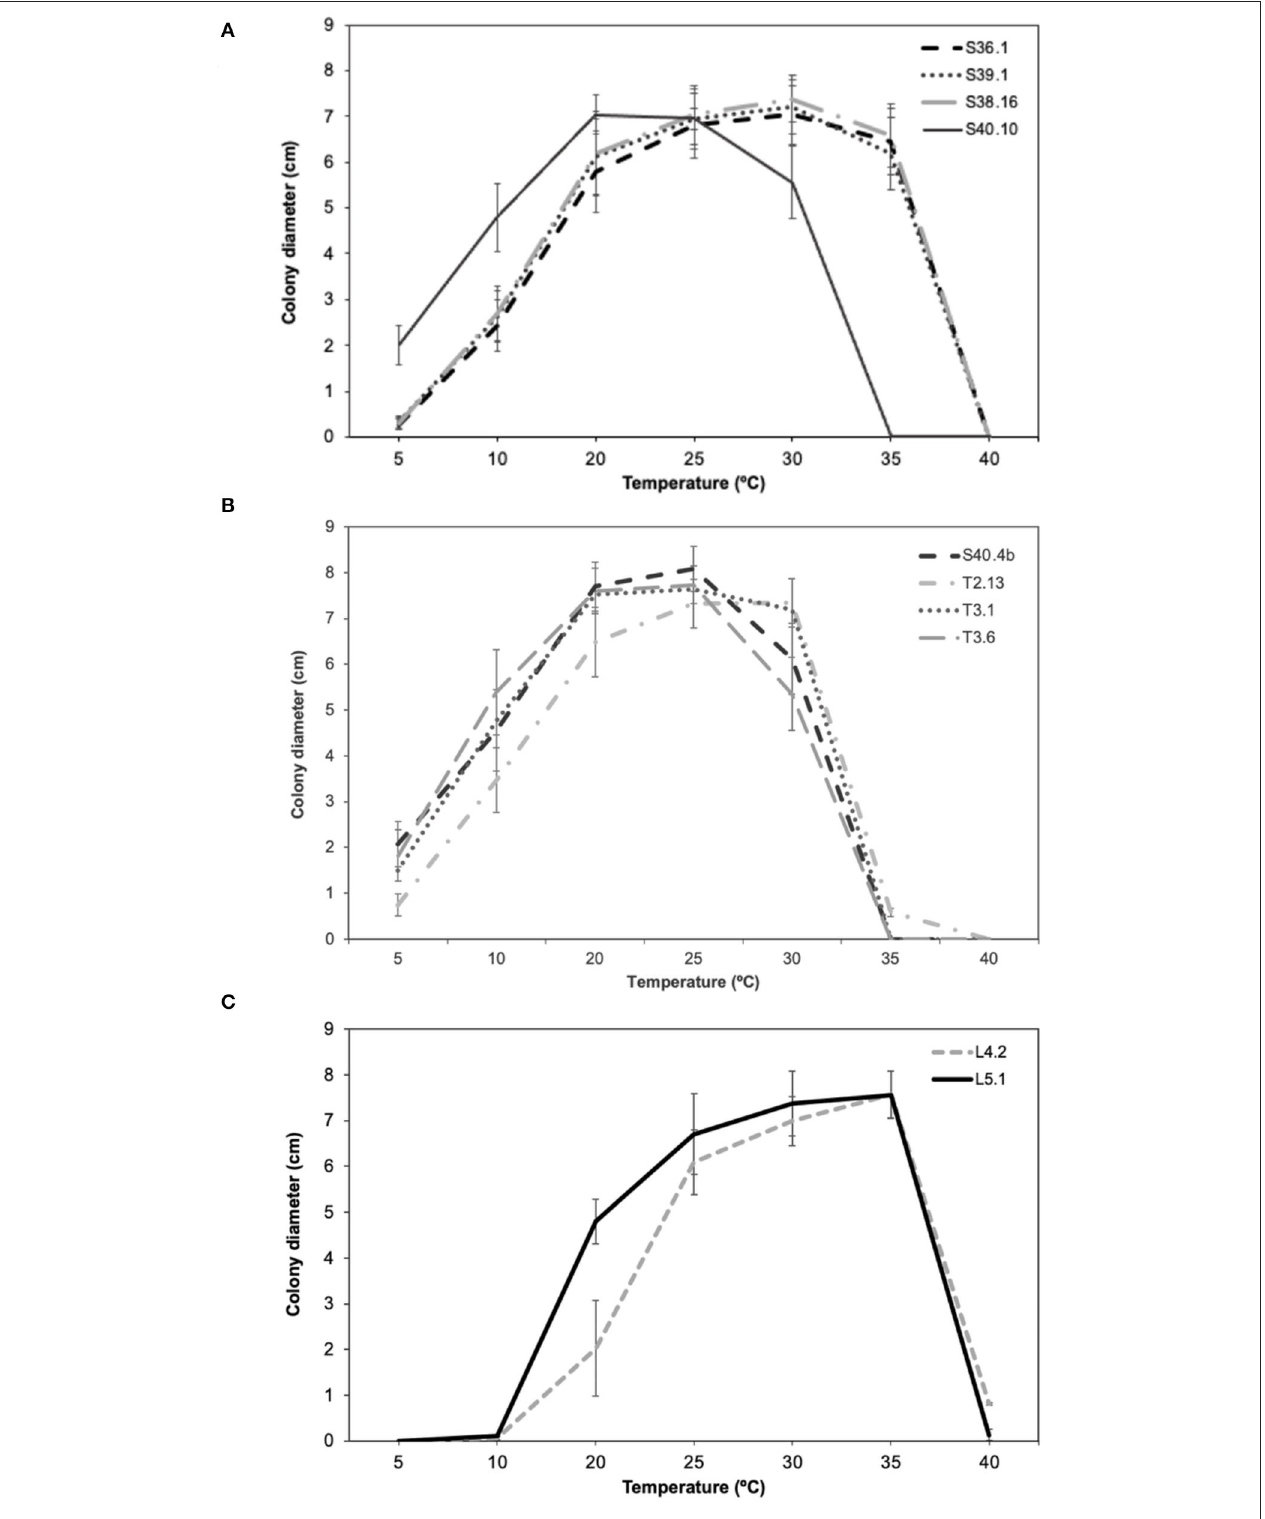
FIGURE 4 | Comparison of mean growth per day ( ± standard error) of (A) Ophiostoma ips (S36.1, S39.1, S38.16, S40.10), (B) Leptographium sp. (S40.4b, T2.13, T3.1, T3.6), and (C) Graphilbum sp. (L4.2, L5.1).